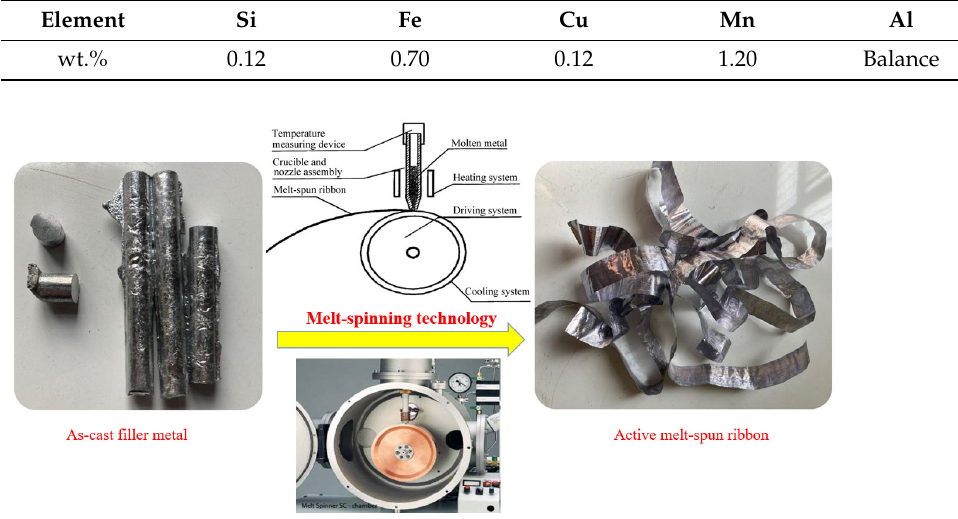
Figure 1. Schematic of melt ‐ spun ribbon preparation process.